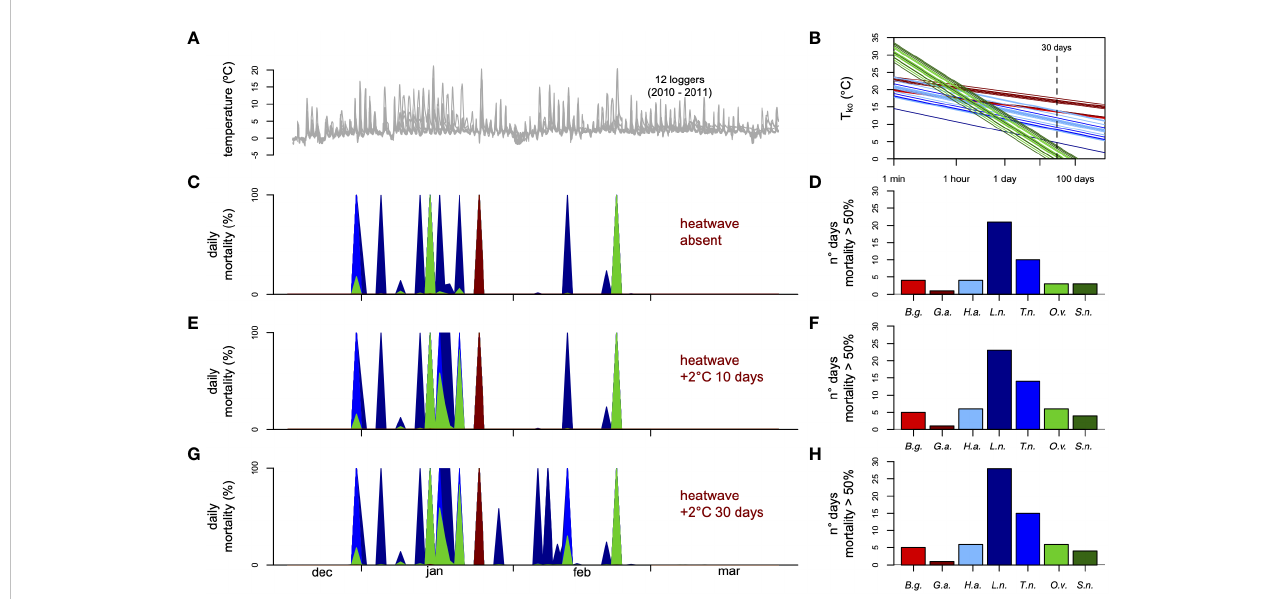
FIGURE 1 Simulated mortality combining the thermal tolerance landscape reconstructed for the seven species and high-resolution environmental temperatures recorded in the (A) intertidal zone, (B) using the thermal-death time (TDT) curves obtained with these CT max and z parameters from three mayor taxa (Chordata, Arthropods and Echinoderms) (Molina et al., 2022). Note that values crossing the TDT curves at 1 min and 30 days correspond to standardized T ko . Simulated mortality procedure by Rezende et al. (Rezende et al., 2020) assumed that organisms could recover every 24 h from an acute heat stress in the intertidal (C) and two scenarios of heatwaves event ( E, G ). Bar plots show sum of days which mortality overpassed 50% to the daily basis of (D) current intertidal thermal condition and the two scenarios of heatwave events ( F, H ). B.g. , Bovallia gigantea (red); G.a. , Bovallia gigantea (dark red); H.a. , Harpagifer antarcticus (light blue); L.n. , Lepidonotothem nudifrons (dark blue); T.n. , Trematomus newnesi (blue); O.v. , Odontaster validus (green); S.n. , Sterechinus neumayeri (dark